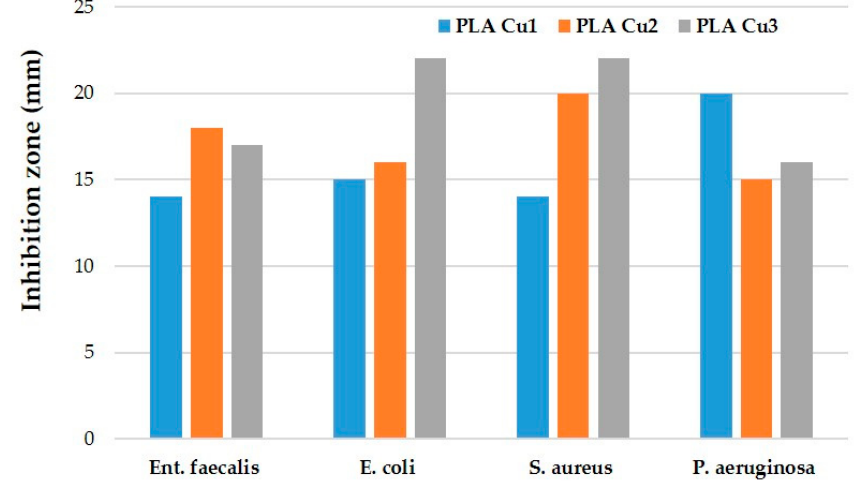
Figure 18. The antibacterial effect of the tested samples .